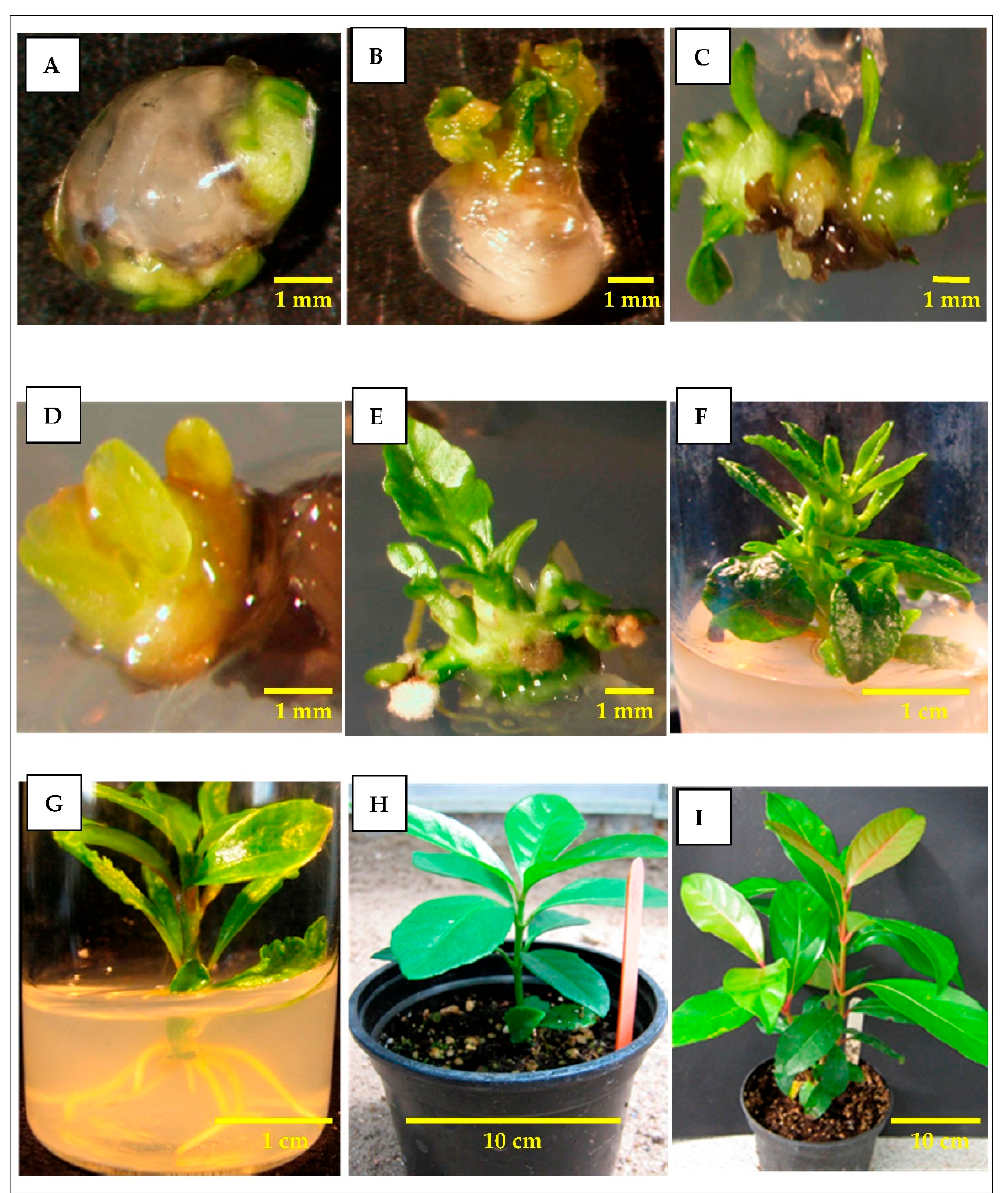
Figure 1. Encapsulated explants of V. dentatum and their conversion into plantlets: ( A ) Encapsulated first-node explant in 2.5% sodium alginate followed by exposure for 30 min to 50-mM calcium chloride. ( B ) Germination commencement of an alginate bead (of shoot tip explant) formed in 2.5% sodium alginate and 100-mM calcium chloride, after 1 week of culture. ( C ) Germination of an alginate bead produced in 2.5% sodium alginate and 50-mM calcium chloride, after 4 weeks of culture. ( D , E ) Germination of artificial seeds stored at 4 °C for 12 weeks after 1 ( D ) and 3 ( E ) weeks of culture. ( F ) Formation of multiple shoots (in 4 weeks) on germinated artificial seed after storage at 4 °C for 12 weeks. ( G ) Rooted microshoot (derived from culture of case F ) in solid MS nutrient medium with 0.5 µ M of Indole-3-acetic acid (IAA). ( H , I ) Microplants established in the greenhouse, after being acclimatized under 75%shading of weekly gradual reduction, 4 ( H ) and 8 ( I ) weeks from the end of the acclimatization period.